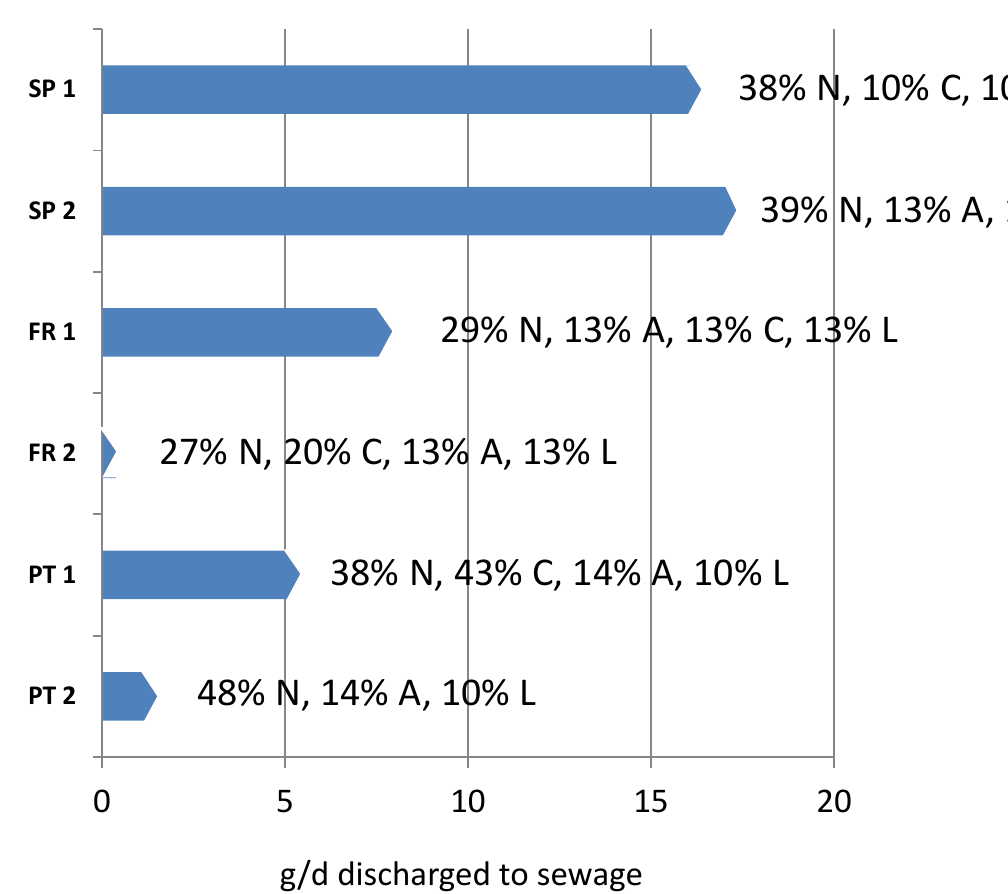
Figure 4. Total discharge of pharmaceuticals (g day −1 ) in the 6 senior residences and main families of compounds discharged according to ATC general category neurological drugs (N), cardiovascular (C), alimentary tract (A), neoplastic (L), anti-infective (J), respiratory (R).